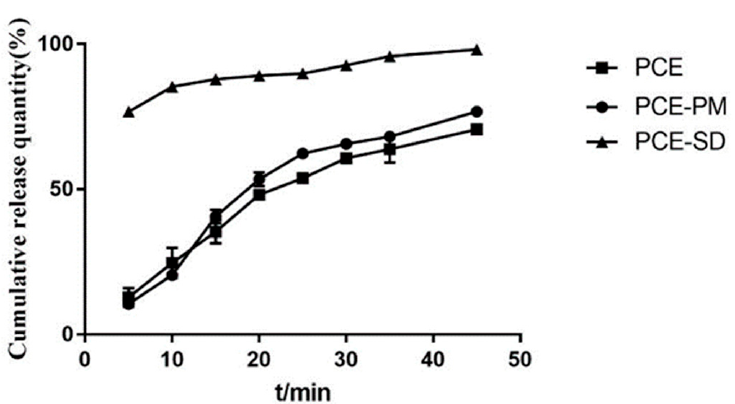
Figure 13. Dissolution curves of PCE, physical mixture and solid dispersion.